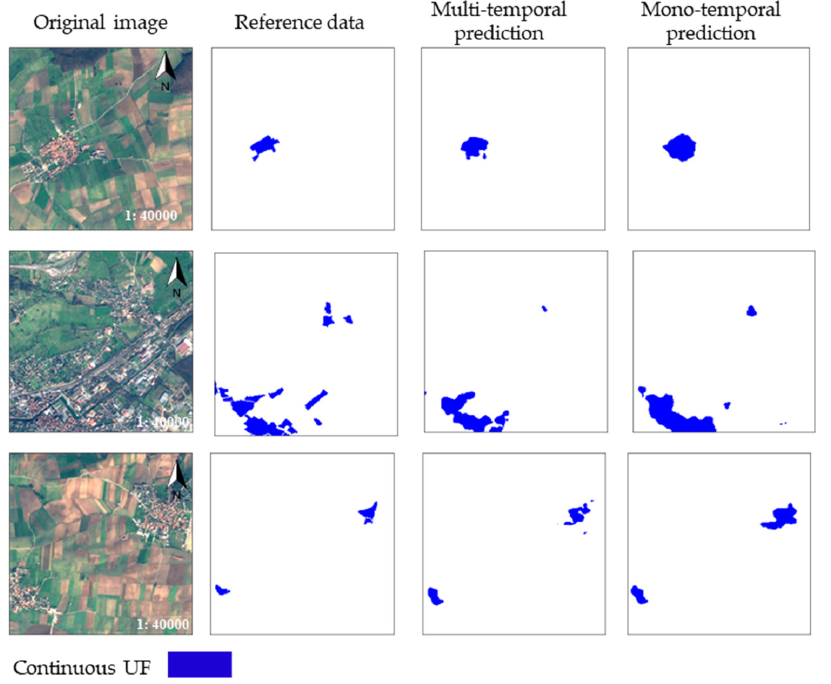
Figure 16. Comparison between predictions of the mono-temporal UNet and the multi-temporal UNet for the class of continuous UF.